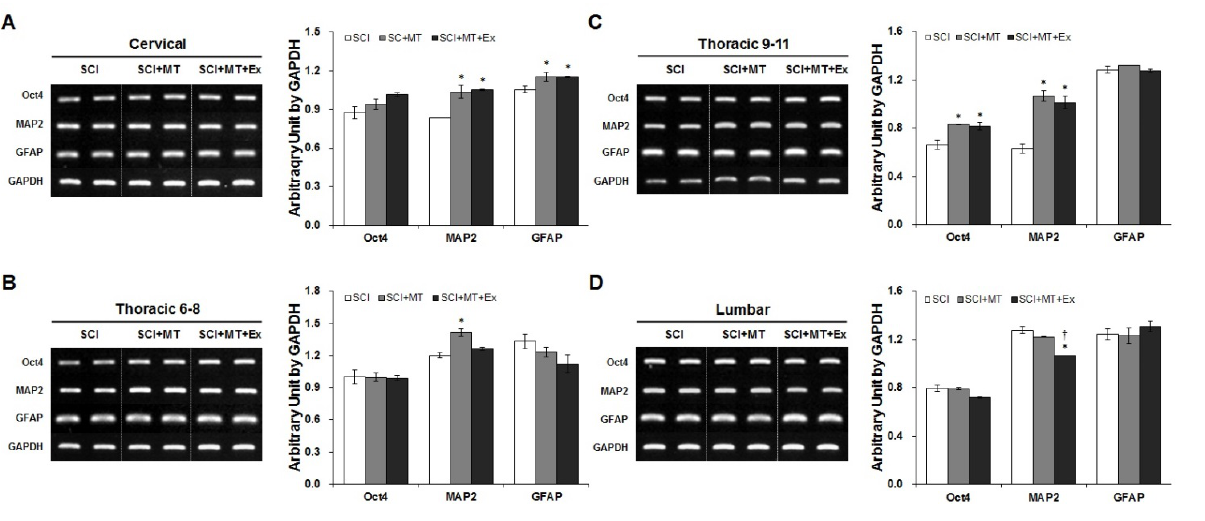
Figure 4. Agonistic effect of therapeutic exercise on endogenous neural stem/progenitor cells proliferation induced by melatonin after SCI. ( A – D ; left panels ) Effect of melatonin and melatonin combined with exercise on mRNA expression of neuronal, glial, and stem/progenitor markers at day 21 after injury. Oct4 , MAP2 , and GFAP expression were evaluated by RT-PCR analysis in the four segments of spinal cord. GAPDH was used as a loading control. ( A – D ; right panels ) Densitometry analysis of band intensity in RT-PCR. Image analysis was carried out using the Image J software Comparisons between experimental groups were conducted by one-way ANOVA using the SPSS software and post hoc Tukey’s tests. Data are expressed as mean ± SEM. (* p < 0.05 vs. SCI; † p < 0.05 vs.